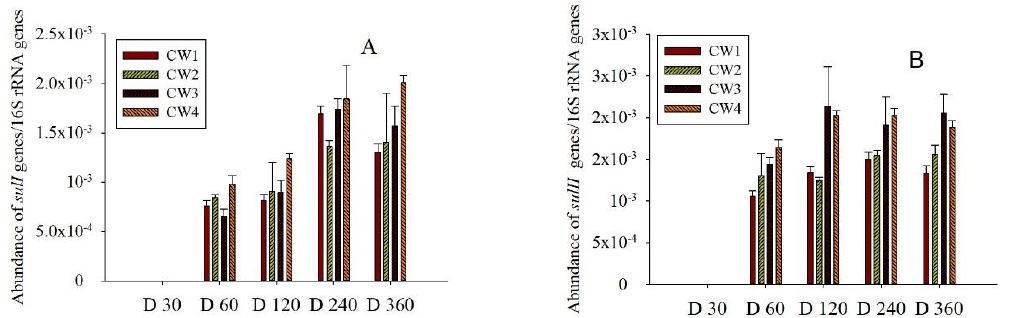
Figure 4. Sul genes ( sulI and sulII ) normalized to 16S rRNA genes in the effluent of CW1, CW2, CW3, and CW4, respectively (mean ± SD, n = 3). ( A ) sulI genes; ( B ) sulII